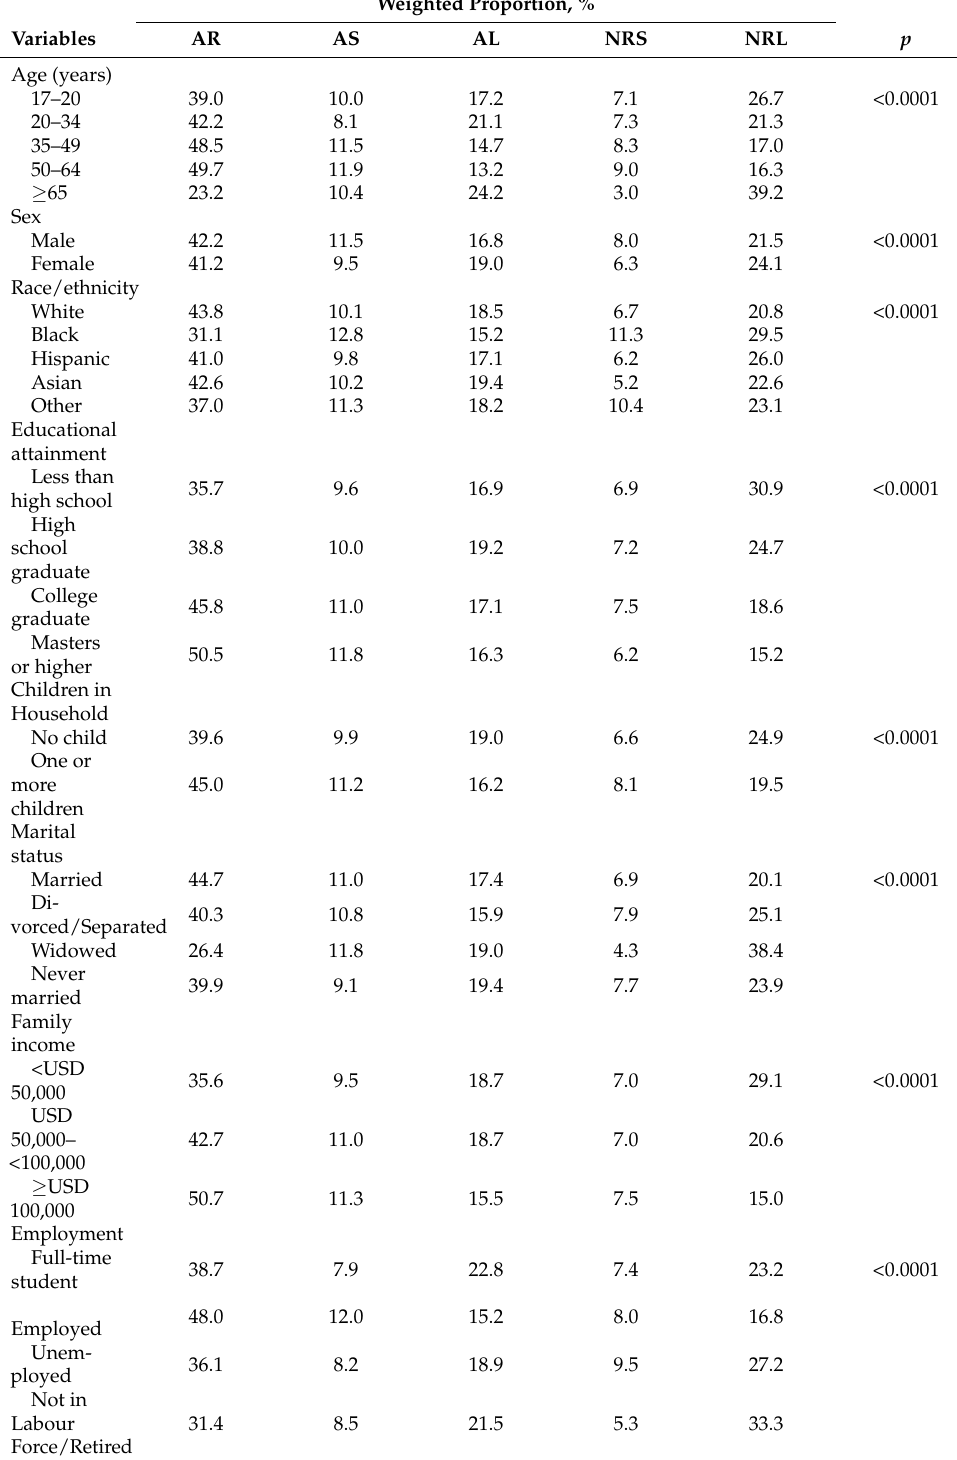
Table 6. Sociodemographic factors associated with adherence of NSF sleep duration recommendation. Weighted Proportion,